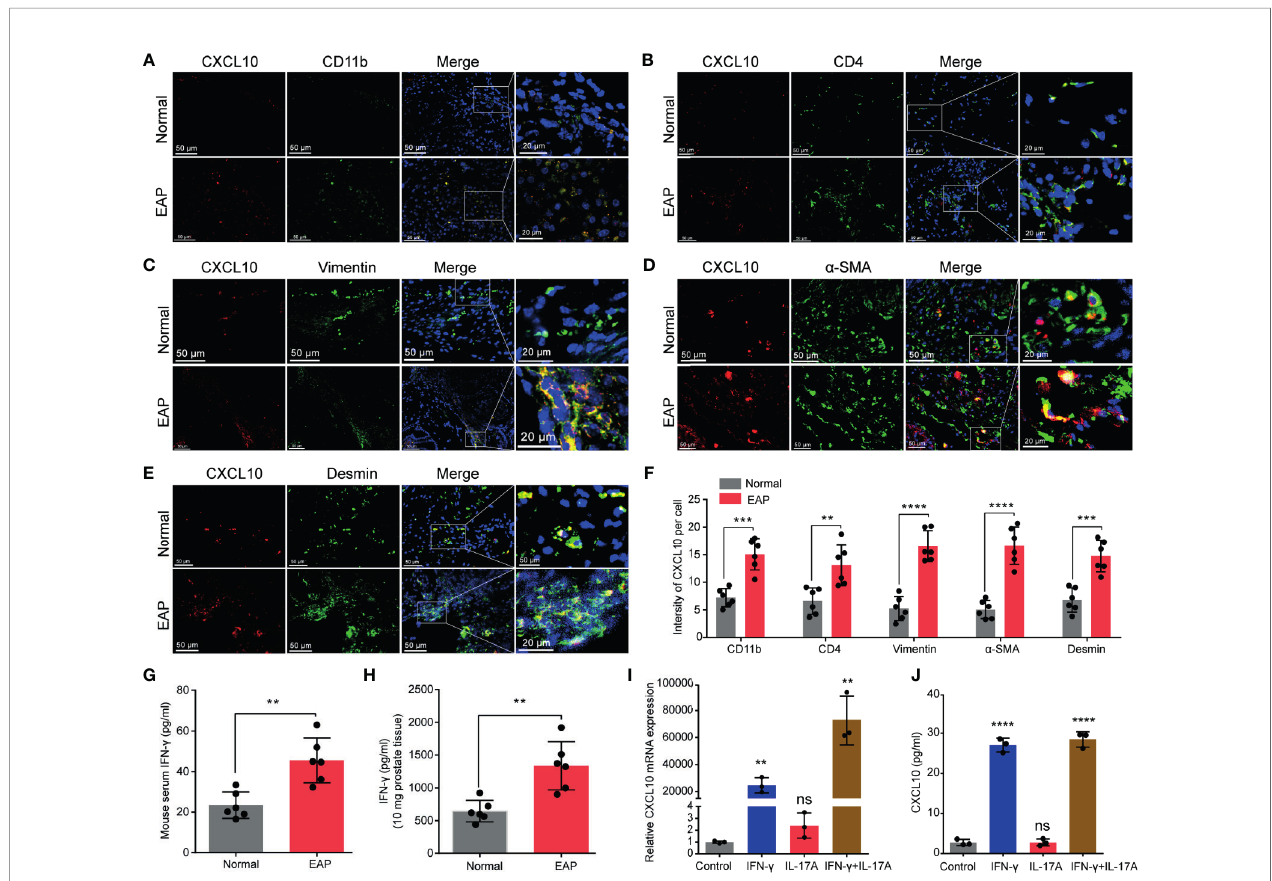
FIGURE 2 | The potential source of CXCL10 in the prostate of EAP mice. Representative photographs of immuno fl uorescence staining for CXCL10 and markers for CD4+ T cells (A) , macrophages (B) , and prostatic stromal cells (C – E) in the prostate of EAP mice. (F) Quanti fi cation of CXCL10 immuno fl uorescence intensity in the experiments of (A – E) . High-expressed levels of IFN- g in the serum (G) and prostate (H) in EAP mice. The expression levels of CXCL10 in WPMY-1 cells were evaluated with RT-qPCR (I) and ELISA (J) when treated with IFN- g , IL-17A, and IFN- g and IL-17A. Data are shown as mean ± SD by unpaired, two-tailed Student ’ s t -test analysis (F – H) , or one-way ANOVA analysis (I, J) . “ ns ” indicates P > 0.05; ** P < 0.01; *** P < 0.001; **** P <